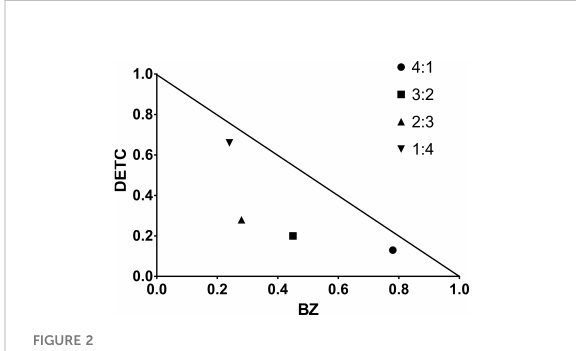
FIGURE 2 Representative isobologram demonstrating the synergistic